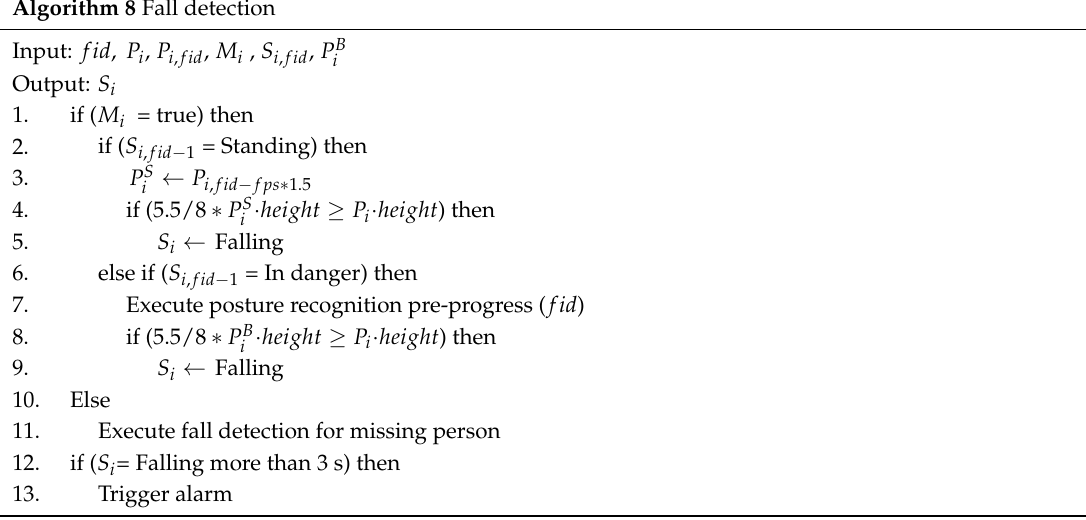
Algorithm 8 Fall detection